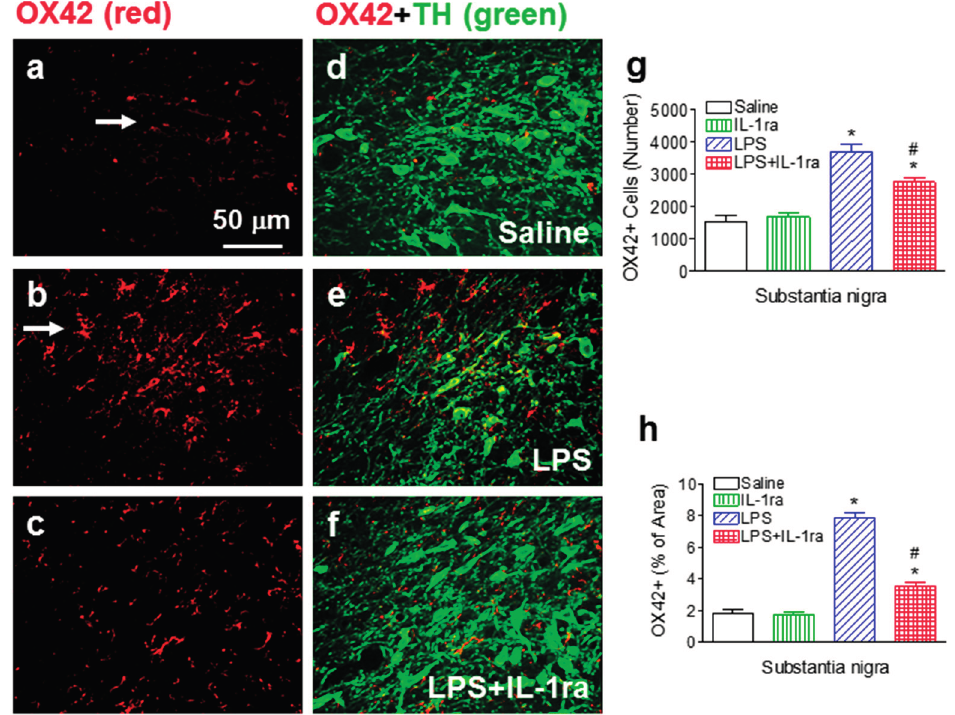
Figure 4. IL-1ra attenuated neonatal LPS-induced microglia activation in the SN area of the P70 rat brain. Representative photomicrographs of OX42+ (red color) ( a – c ); TH+ (green color) cells, or the merged double staining images ( d – f ) in the rat brain; ( a , d ) saline-treated group; ( b , e ) LPS-treated group; ( c , f ) LPS+IL-1ra group. Scale bar: 40 μ m; Microglia activation was quantified by counting the number of OX42+ cells in the SN ( g ) or calculating the percentage area of OX42+ staining in the digitally acquired images from the SN ( h ). The results are expressed as the mean ± SEM of six animals in each group, and analyzed by two-way ANOVA. * p < 0.05 represents significant difference for the LPS group as compared with the saline group. # p < 0.05 represents significant difference for the LPS+IL-1ra group as compared with the LPS